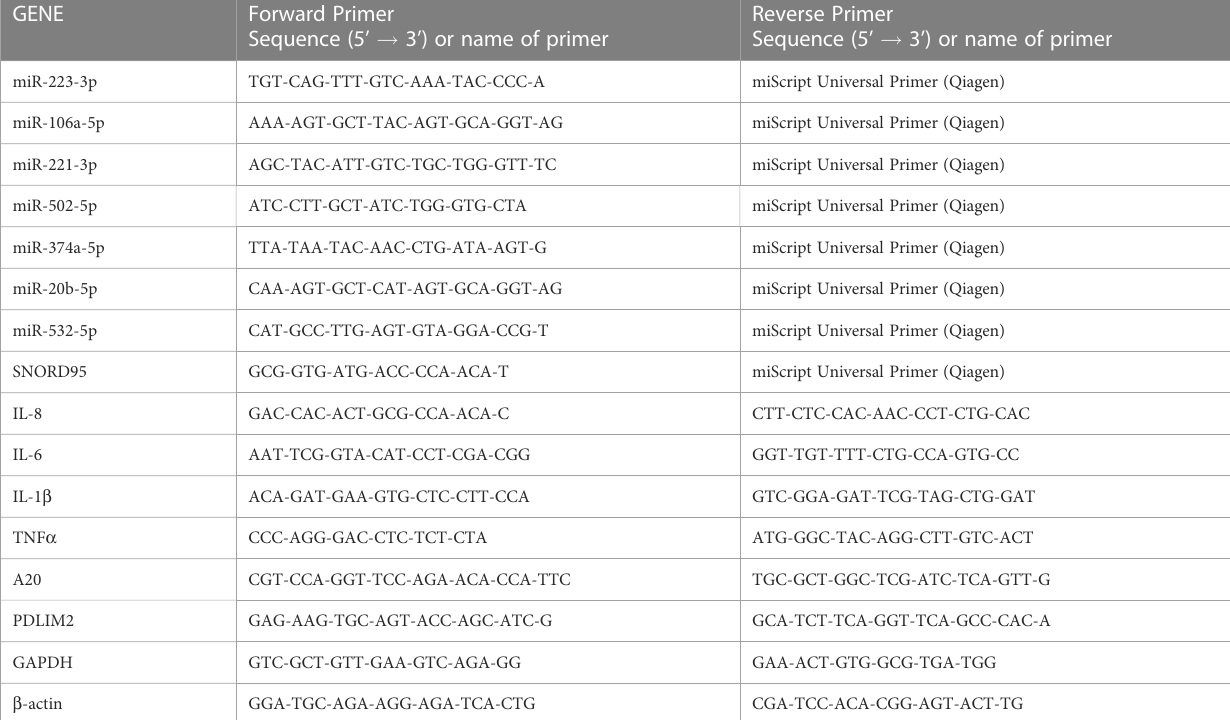
TABLE 2 Oligonucleotide primers used for miRNA and mRNA qRT-PCR analysis. GENE Forward Primer Sequence (5 ’ ! 3 ’ ) or name of primer